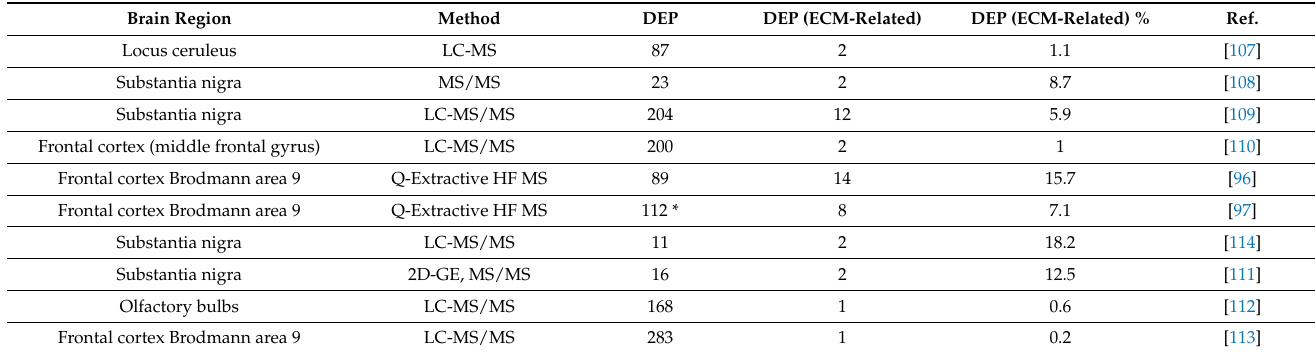
Figure 4. Summary of data from both proteomic and transcriptomic studies. The origin of the in- cluded articles ( A ); brain region from which the samples were taken for transcriptomic studies ( B ); methods applied for transcriptomic analysis ( C ); percentage of ECM-related di ff erentially expressed proteins per brain region ( D ) (SN: substantia nigra; FC: frontal cortex; LC: locus ceruleus; OB: olfac- tory bulbs; FL: frontal lobe ; PC: posterior cingulate cortex; DEP: di ff erentially expressed protein).